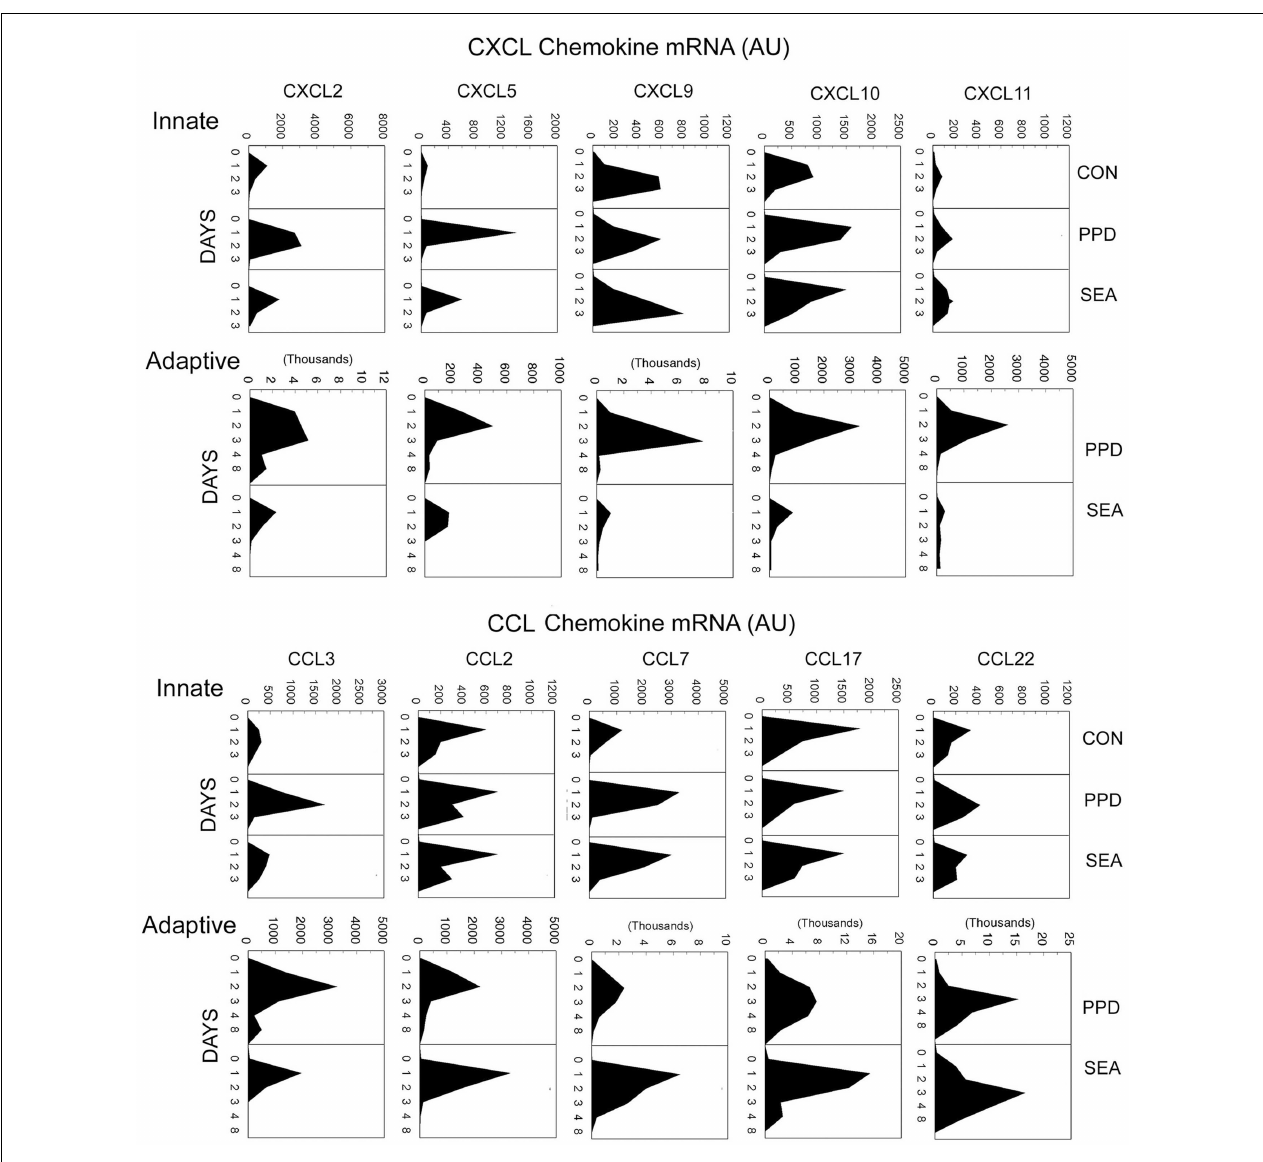
designated time points for mRNA extraction and cDNA preparation. Chemokine transcript levels were determined by semiquantitative real-time RT-PCR. Mean arbitrary units (AU) were derived from five to six individual lungs per